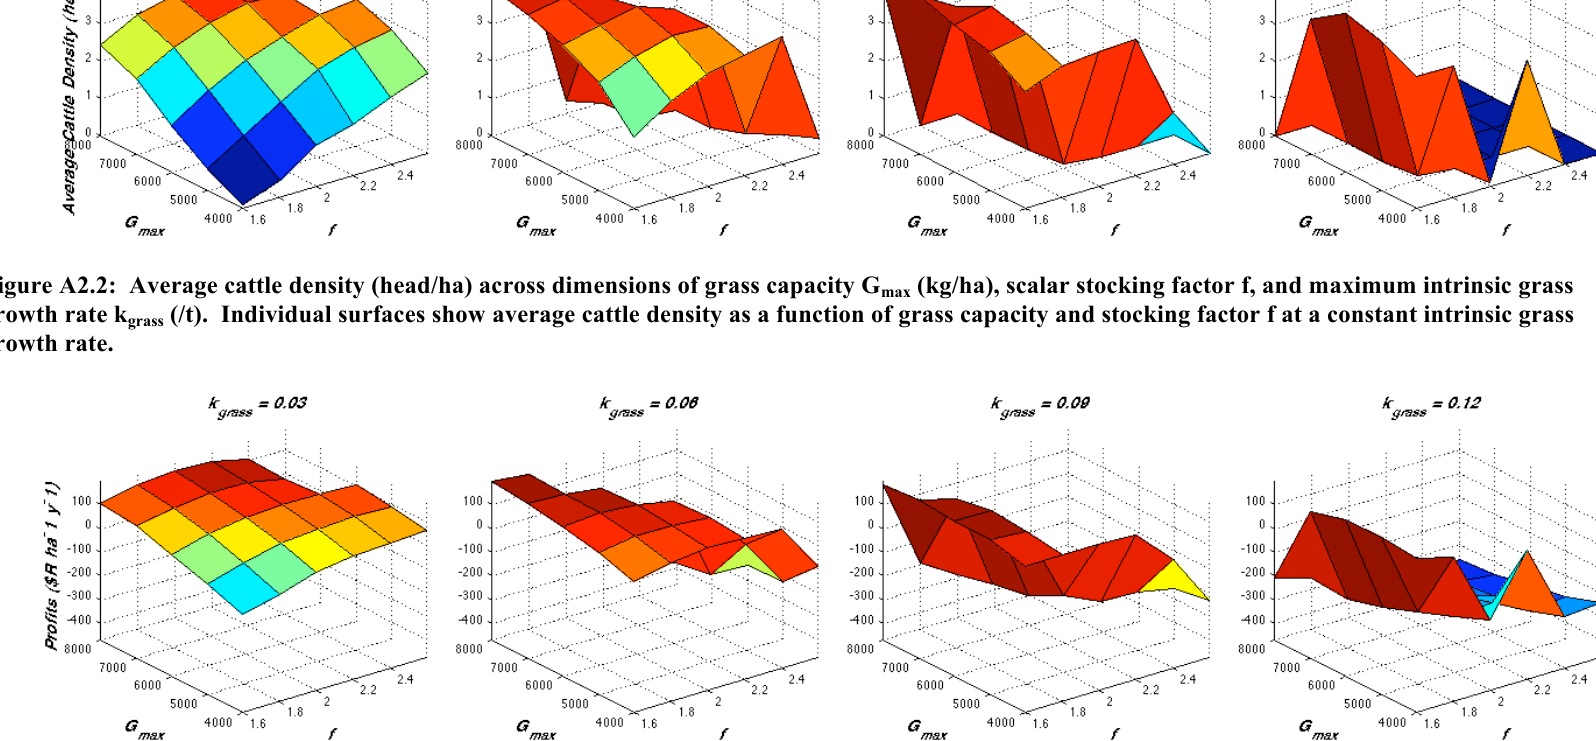
(kg/ha), scalar stocking factor f, and maximum intrinsic grass growth max